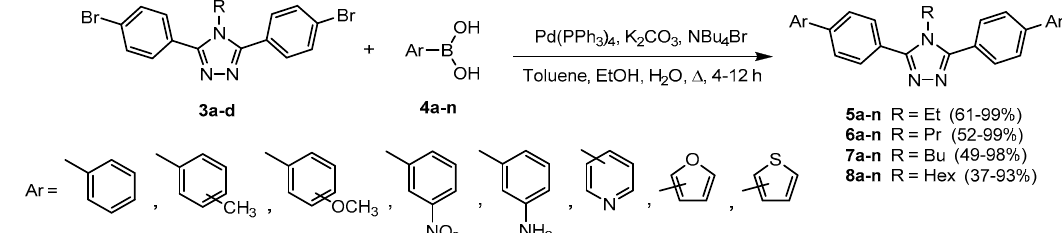
Scheme 2. The conventional Suzuki cross-coupling reaction for 4-alkyl-3,5-bis(4-bromophenyl)-4 H - 1,2,4-triazole moiety. Reagents and conditions: aryl dibromide 3a–d (1.00 mmol), arylboronic acid 4a–n